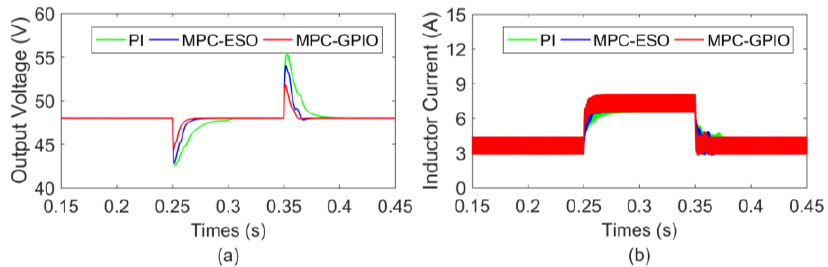
Figure 7. Dynamic response of TIBC under step load disturbance at 0.25 s and 0.3 s: ( a ) output voltage; ( b ) inductor current.